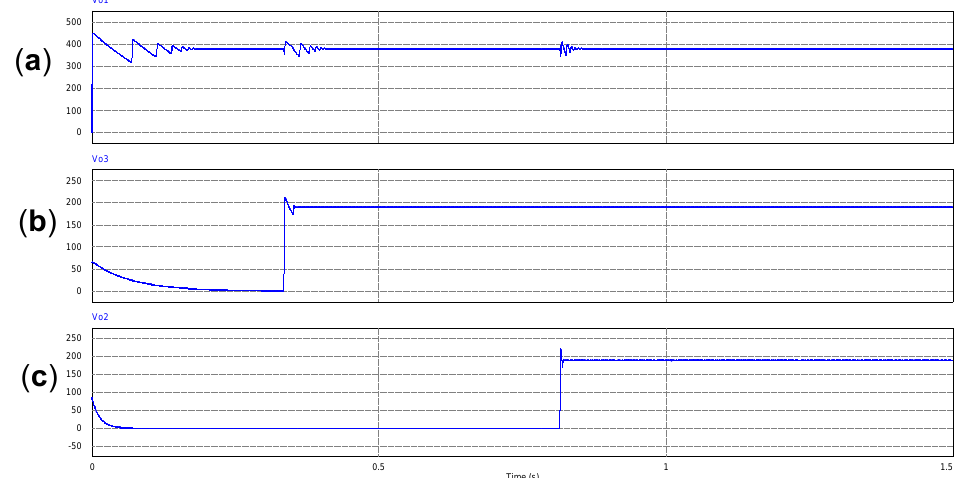
Figure 27. First set of simulation results, ( a ) primary DC bus, ( b ) 1.2 KW converter output voltage and ( c ) secondary DC bus.